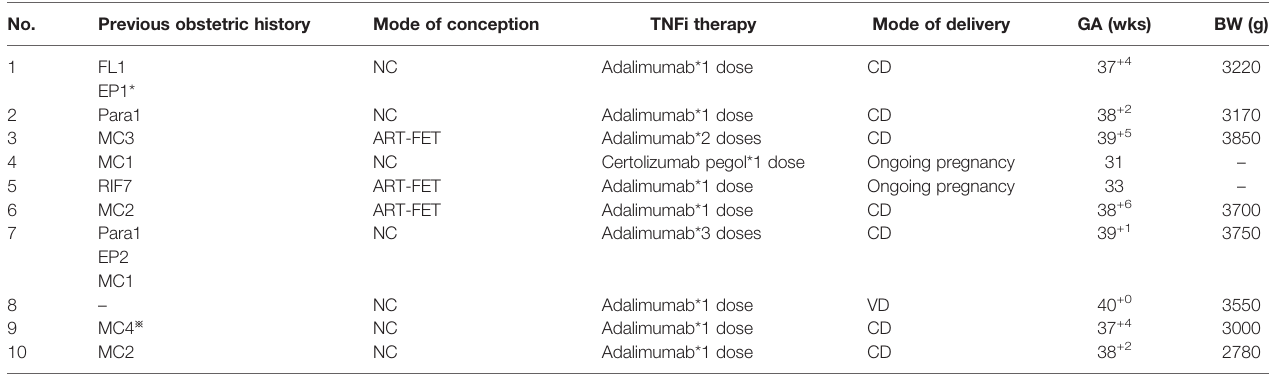
TABLE 2 | Previous obstetric history and current pregnancy outcomes.